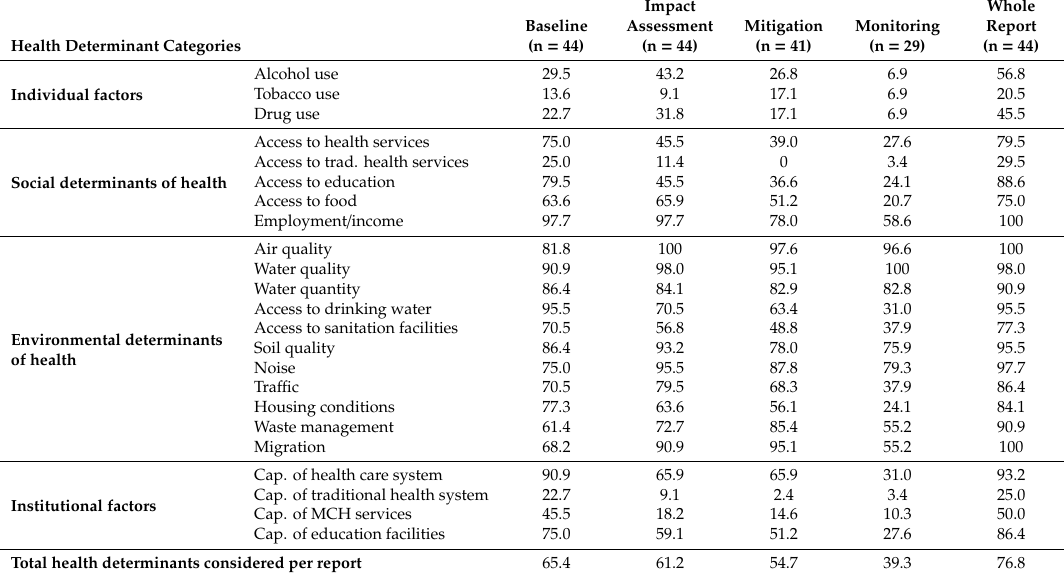
Table A3. Inclusion of health determinants in impact assessment reports.